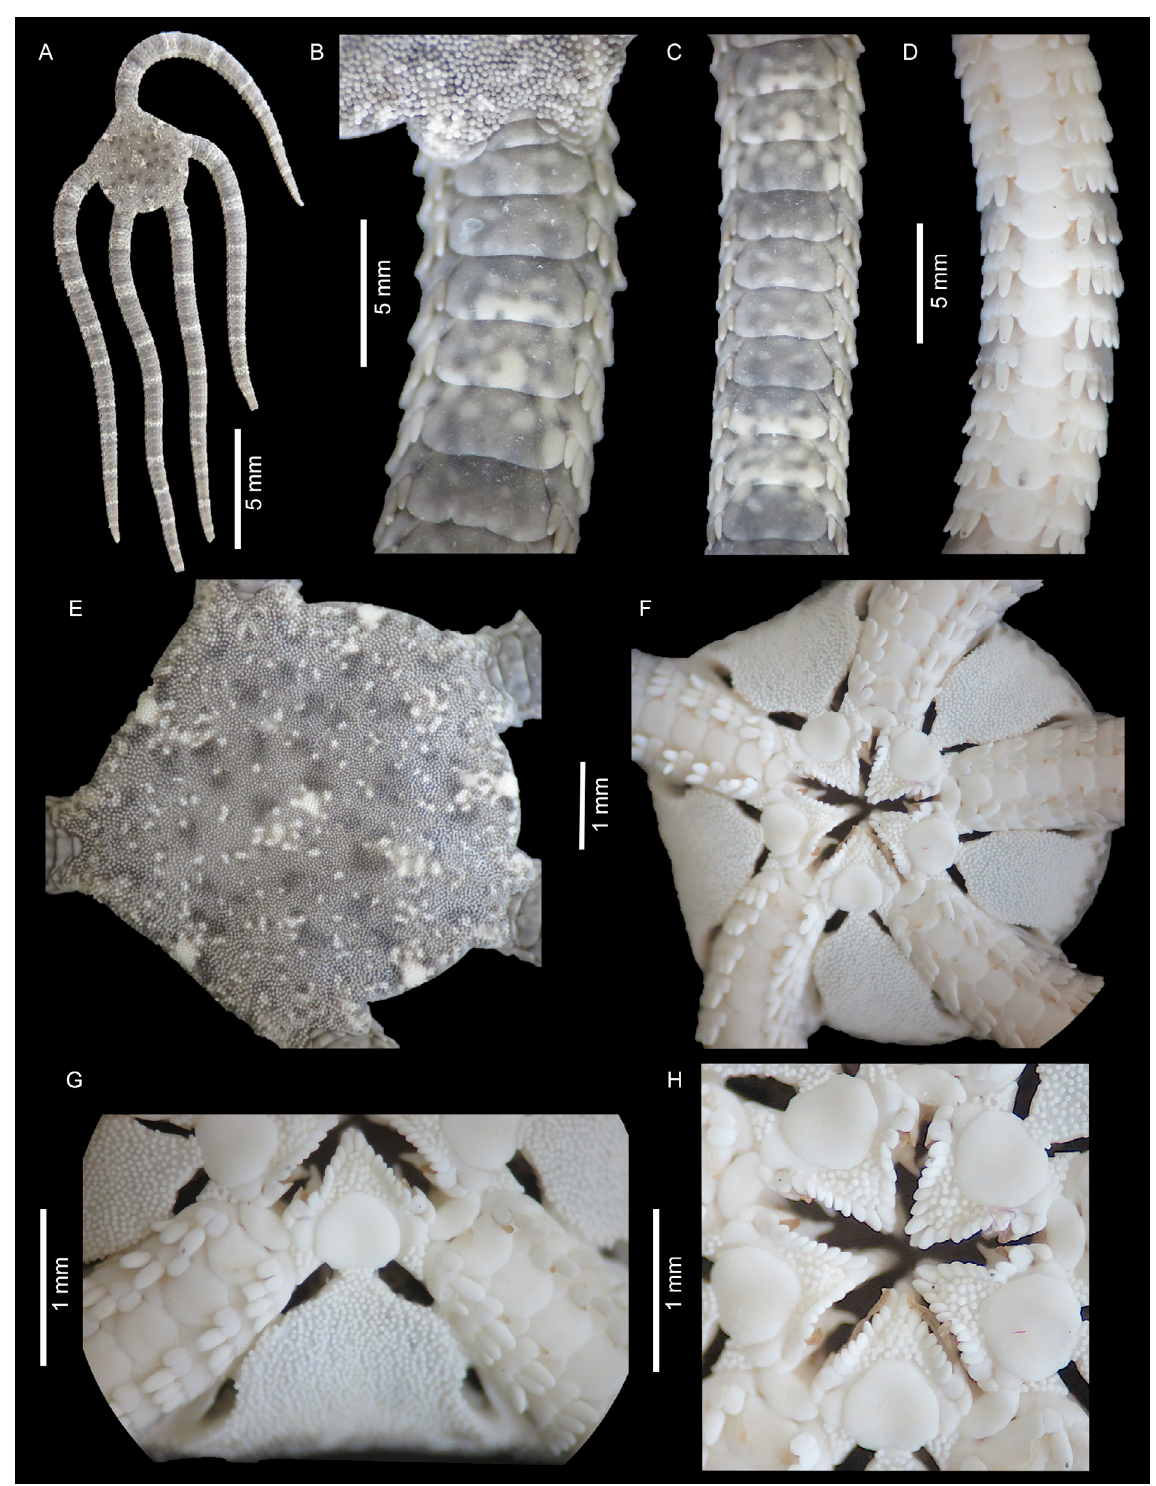
Fig. 3. Ophioderma hendleri sp. nov., paratype (ICML-UNAM 10582, DD = 4.8 mm). A . Dorsal view. B . Basal dorsal arm. C . Dorsal arm. D . Ventral arm. E . Dorsal disc. F . Ventral disc. G . Interradii. H .